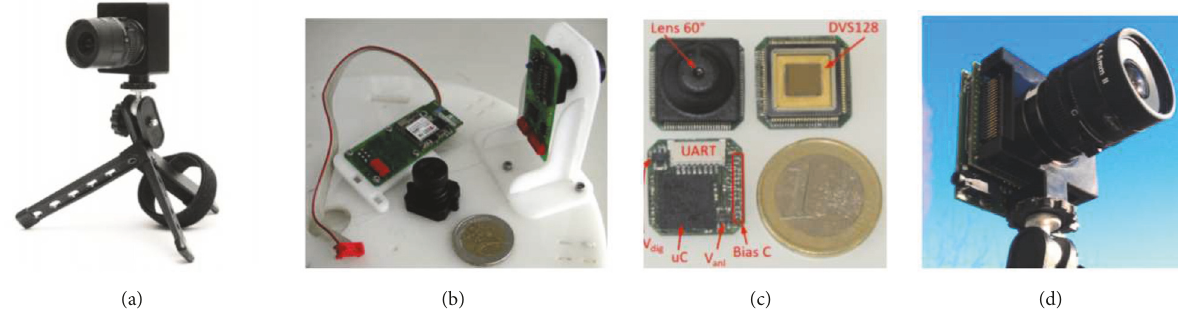
Figure 2: Different versions of neuromorphic vision sensors: (a) Dynamic Vision Sensor 128 (DVS128). (b) Embedded Dynamic Vision Sensor (eDVS). (c) Miniature Embedded Dynamic Vision Sensor (meDVS). (d) Dynamic and Active Pixel Vision Sensor (DAVIS). This figure is adopted from [11].